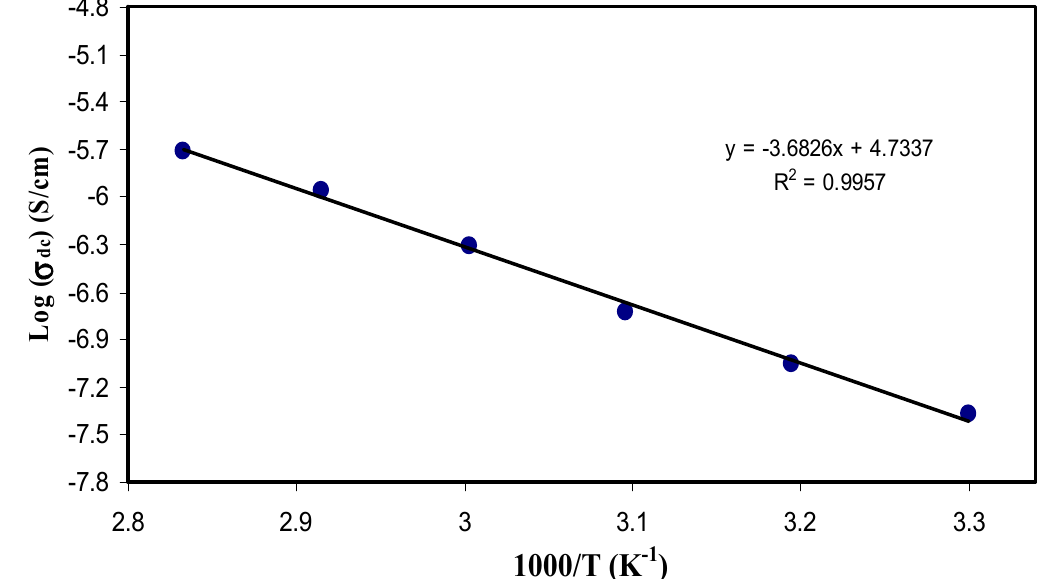
Figure 11. Logarithm of DC conductivity ( σ dc ) as a function of the inverse of temperature (1000 / T). The linear behavior of DC conductivity versus the reciprocal of temperature reveals that ion transport follows the Arrhenius model.